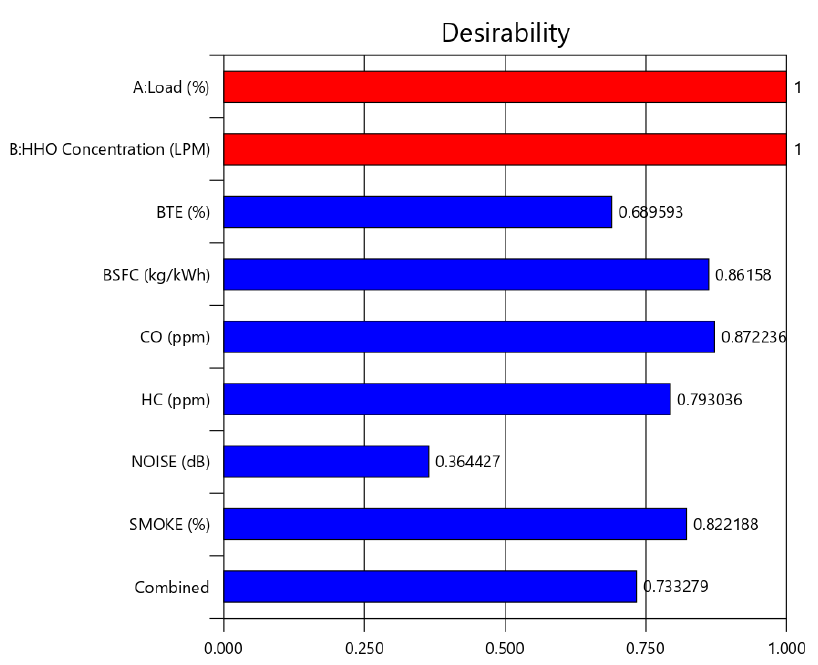
Figure 16. Desirability chart.